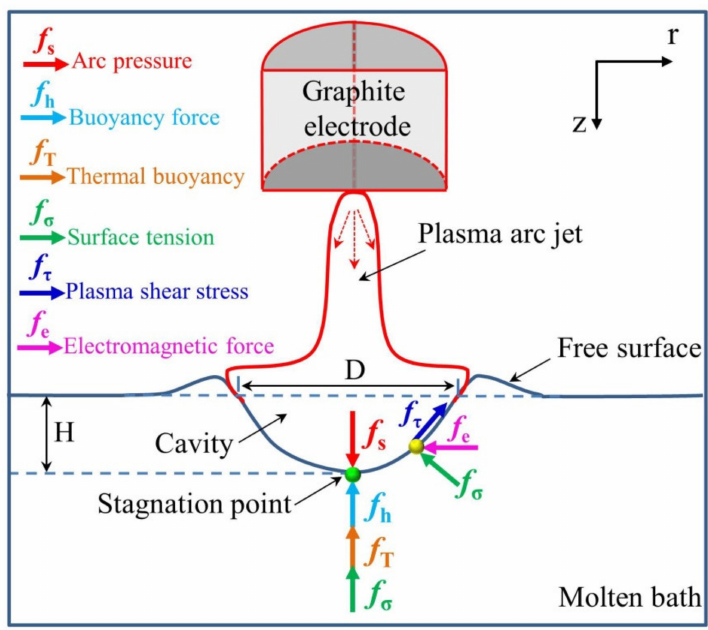
Figure 6. Schematic diagram of cavity-formation